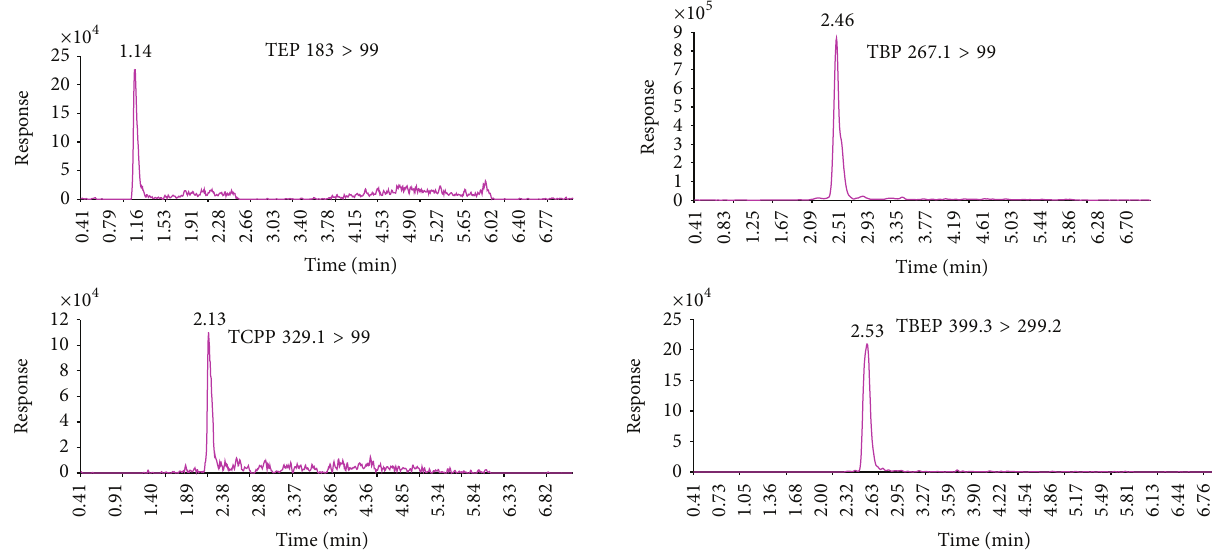
Figure 9: Ion chromatograms of OPEs in the Pearl River water samples.